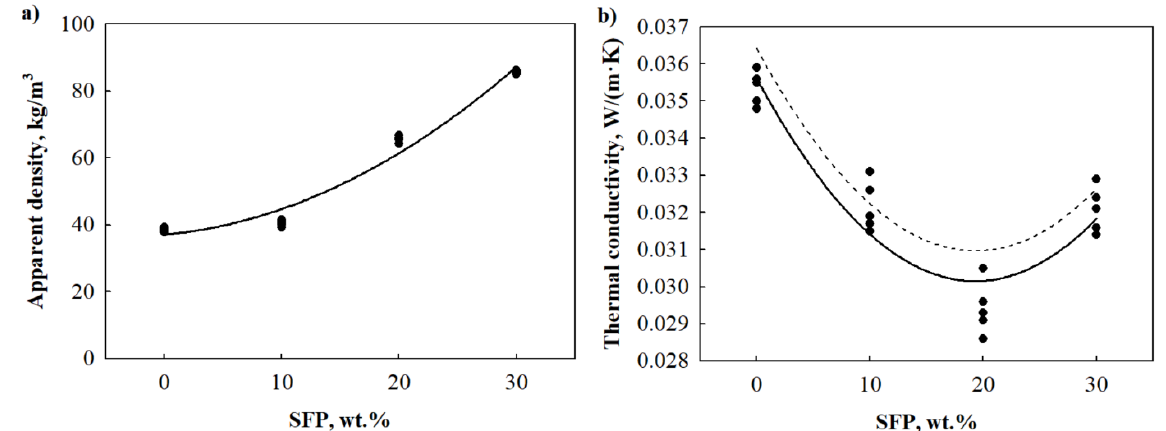
Figure 3. Dependence of properties on the amount of SFP filler: ( a ) apparent density and ( b ) thermal conductivity. • — individual values of thermal conductivity at specified amount of SFP filler; Continuous line—dependence line; Dotted line—upper limit at 90% confidence level.